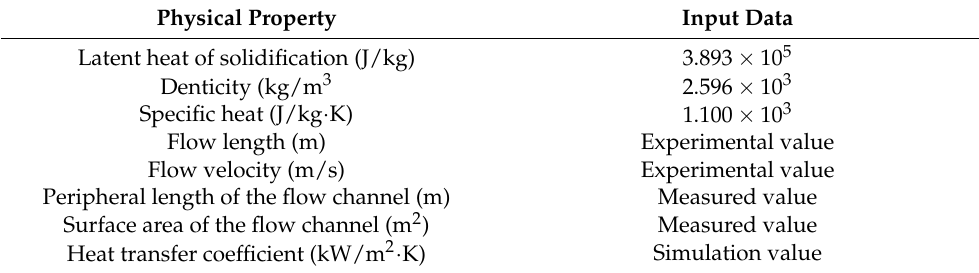
Table 3. Physical property data of Al–7%Si–0.3%Mg alloy(For